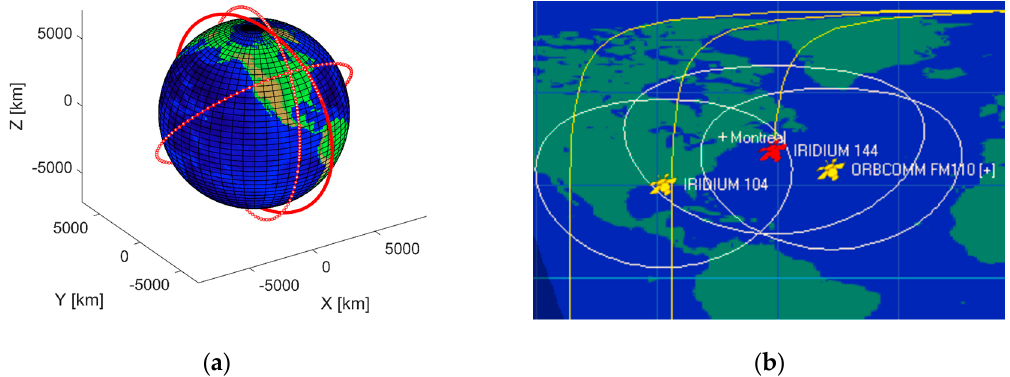
Figure 6. ( a ) Position of satellites during one orbital period and ( b ) the location of satellites over Montreal’s region.